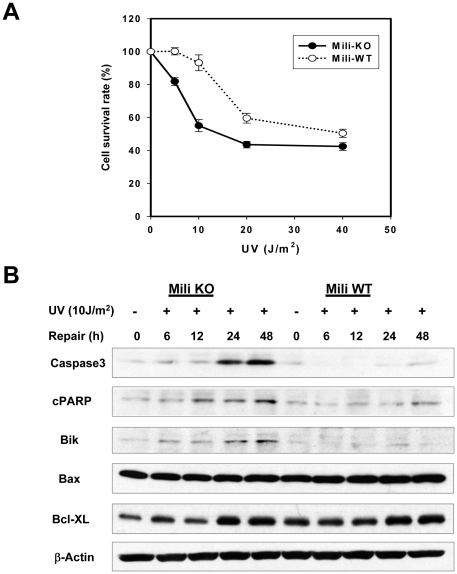
Mili-/- MEFs are more susceptible than WT MEFs to apoptosis induced by UV light.
A. Survival rate was significantly decreased in the mili-/- MEFs treated with various doses of UV (p<0.01). The relative cell survival rate was determined by methylene blue staining 72 or 96 hours after treatment. Shown are the data derived from 96 hrs after irradiation. B, DNA damage-associated apoptotic proteins were up-regulated in the UV-treated mili-/- MEFs. The data shown are a representative of three experiments in triplicate. Caspase-3: activated caspase-3; cPARP: cleaved PARP.